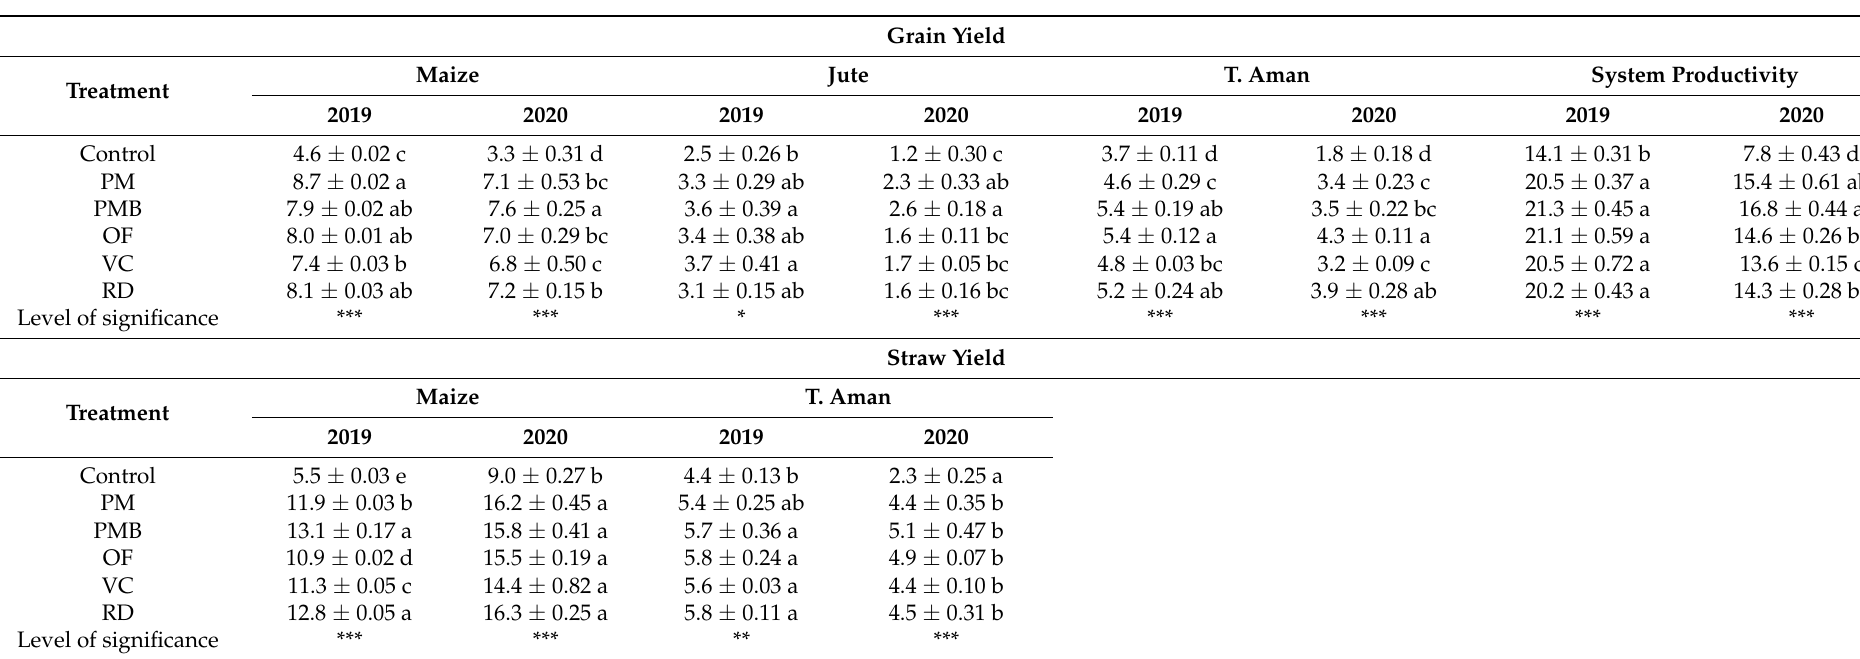
Table 9. Effects of different treatments on crop yield and system productivity of Maize-Jute-T. Aman rice cropping pattern in charland soil.